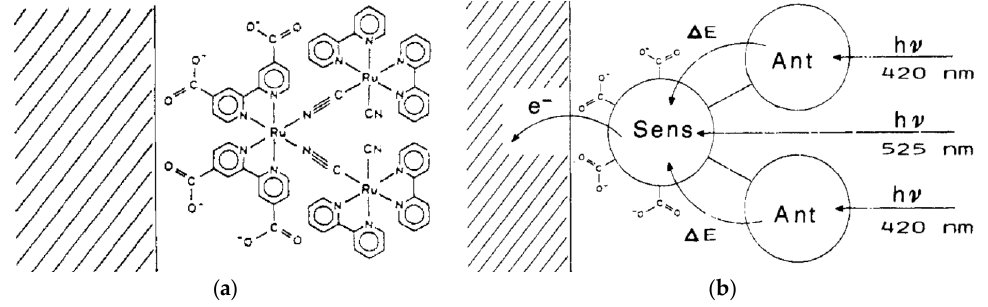
Figure 12. Illustrative representation of the adsorption mode of the trinuclear complex on the TiO 2 surface ( a ) and block diagram showing the function of the trinuclear complex as an antenna-sensitizer molecular device ( b ) [62].